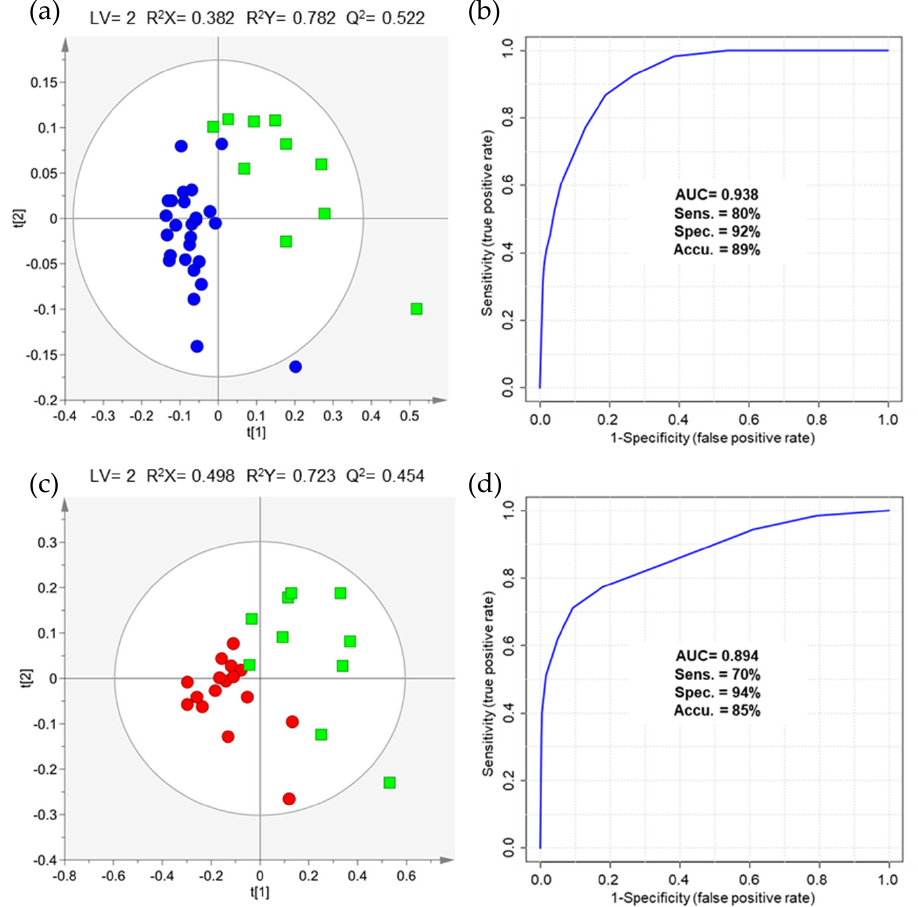
Figure 2. ( a ) PLS-DA scores scatter plot and ( b ) ROC curve obtained for urinary volatile profile (VOCs and VCCs concatenated matrix), after variable selection (36 observations × 486 variables), of patients diagnosed with MIBC (stages ≥ T2, green squares, n = 10) and NMIBC (stage Ta/Tis, blue circles, n = 26). ( c ) PLS-DA scores scatter plot and ( d ) ROC curve obtained for urinary volatile profile (VOCs and VCCs concatenated matrix), after variable selection (27 observations × 856 variables), of patients diagnosed with MIBC (stages ≥ T2, green squares, n = 10) and NMIBC (stage T1, red circles, n = 17).